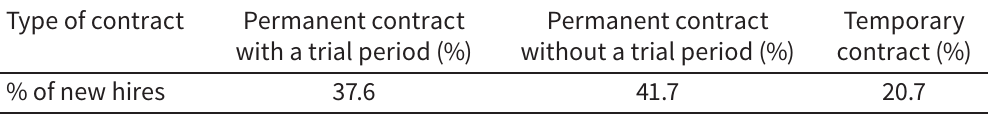
Distribution of contract type for new hires in 2012 Type of contract Permanent contract Permanent contract Temporary with a trial period (%) without a trial period (%) contract (%) % of new hires 37.6 41.7